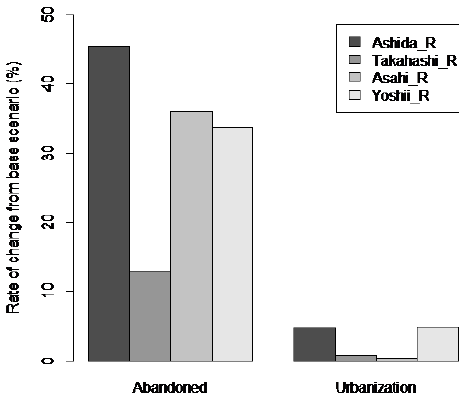
Figure 3. Rate of change in sediment